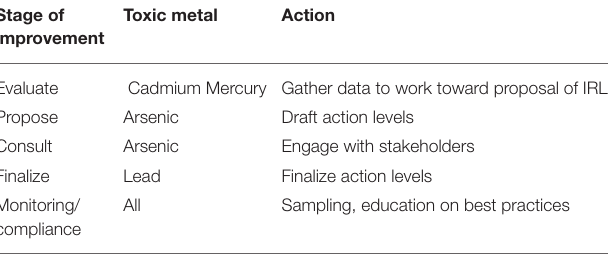
TABLE 7 | Phase 2 FDA’s Closer to Zero Action Plan: April 2022 - April 2024.